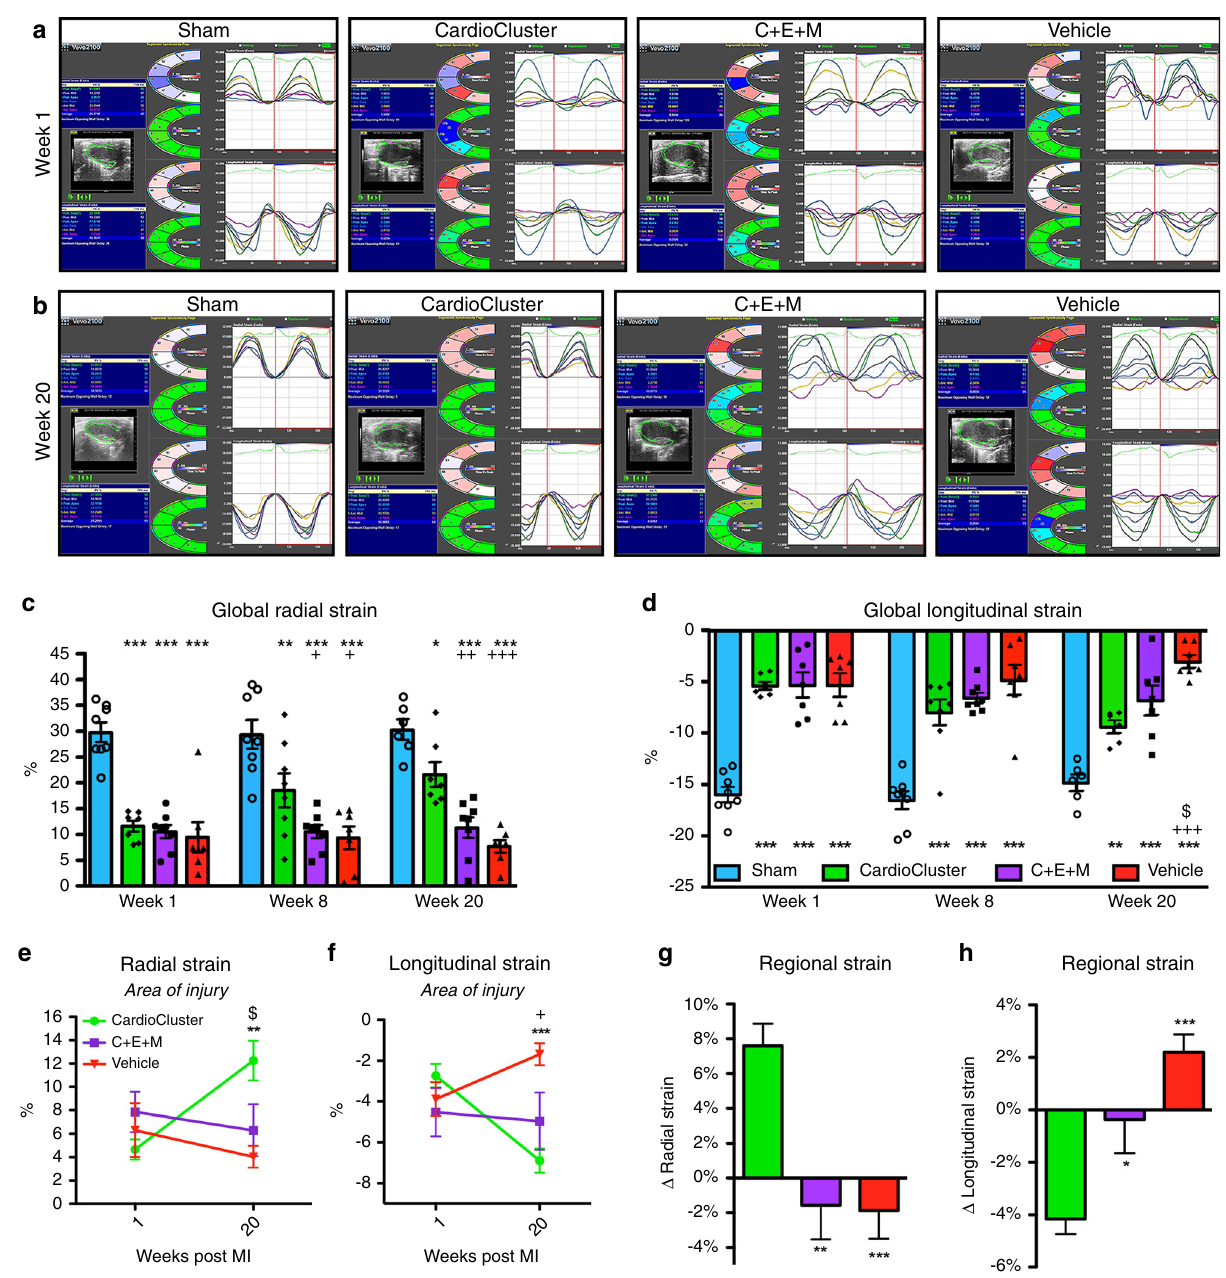
Fig. 5 Impact of CardioClusters on cardiac function measured by cardiac strain. a , b Representative images of long-axis echocardiography recording (left panel), with cross-sectional segment synchronicity map (middle panels), and radial and longitudinal strain curves (right panels) at week 1 ( a ) and week 20 ( b ). Strain curves (representing strain measures over time) are generated for the 6 standard myocardial regions, with a 7 th line (shown in black) denoting the average strain. c , d Speckle tracking echocardiography analysis used to determine global peak radial strain (%) ( c ) and global peak longitudinal strain (%) ( d ) at week 1, week 8, and week 20. Data represents mean (n number of mice as indicated) ± SEM. Data are presented as two-way ANOVA with Tukey ’ s multiple comparisons test, ( c ) *** p < 0.001, versus sham, week 1; ** p = 0.003, *** p < 0.001, versus sham, + p = 0.041(C + E + M), + p = 0.018 (vehicle), versus CardioCluster, week 8; * p = 0.048, *** p < 0.001, versus sham, ++ p = 0.007, +++ p < 0.001, versus CardioCluster, week 20. d *** p